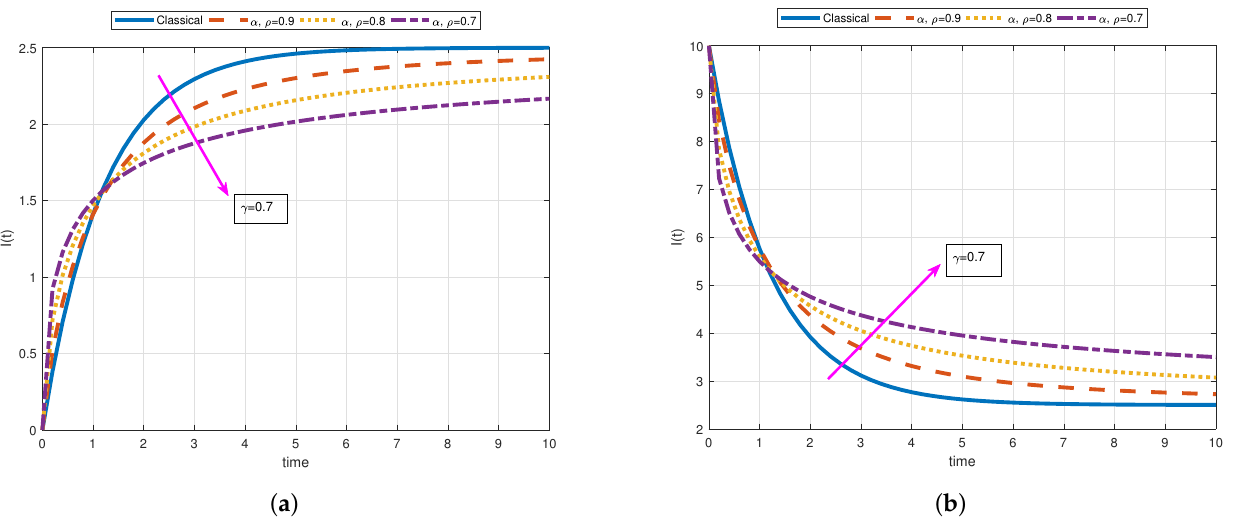
Figure 9. The figure ( a ) corresponds to the function I ( t ) with constant source for various values of α , ρ , and γ in order to show the effect of arbitrary parameter γ when γ = 0.7, C = 0.5 F, L = 2.4, e 0 = 5 V, I ( 0 ) = 0, and similarly the figure ( b ) is plotted to show the effect of γ on solution curves when γ = 0.7, C = 0.5 F, L = 2.4, e 0 = 5 V, and I ( 0 ) =